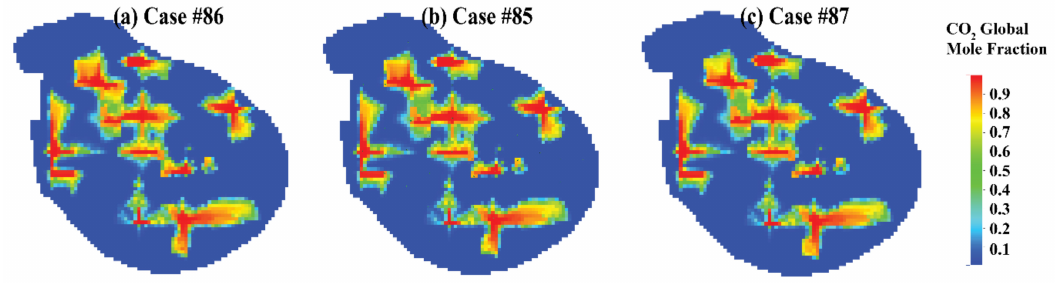
Figure 7. Simulated CO 2 global mole fraction at the end of the CO 2 -EOR period for ( a ) Case #86, ( b ) Case #85, and ( c ) Case #87.